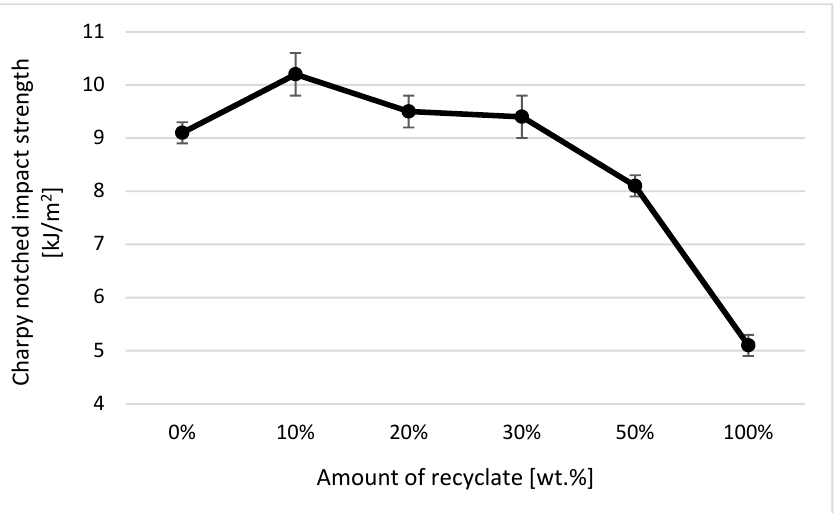
Figure 21. Dependence of the notched strength on the amount of recycled material before exposing samples to elevated temperature.